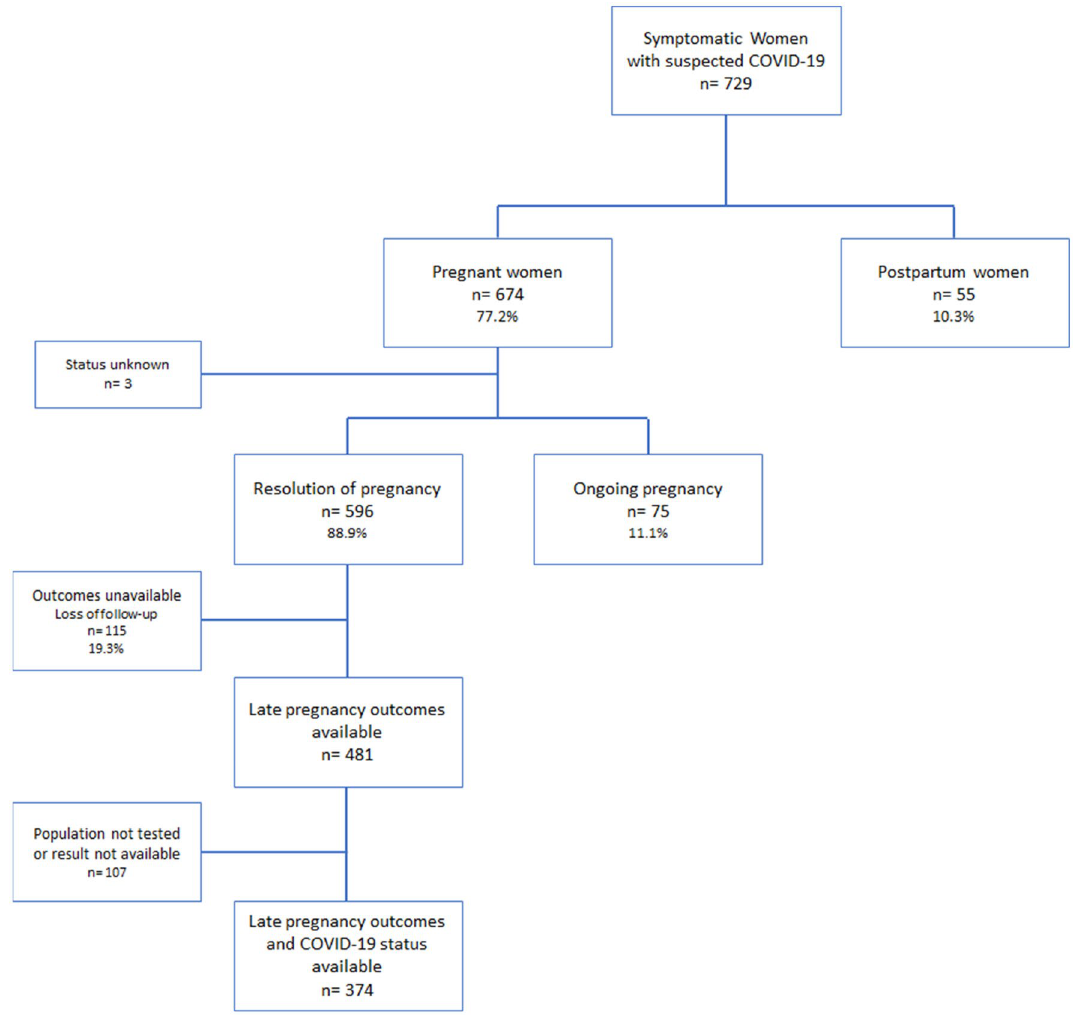
Figure 2. Flowchart of participants included in the REBRACO study according to the pregnancy status and outcomes